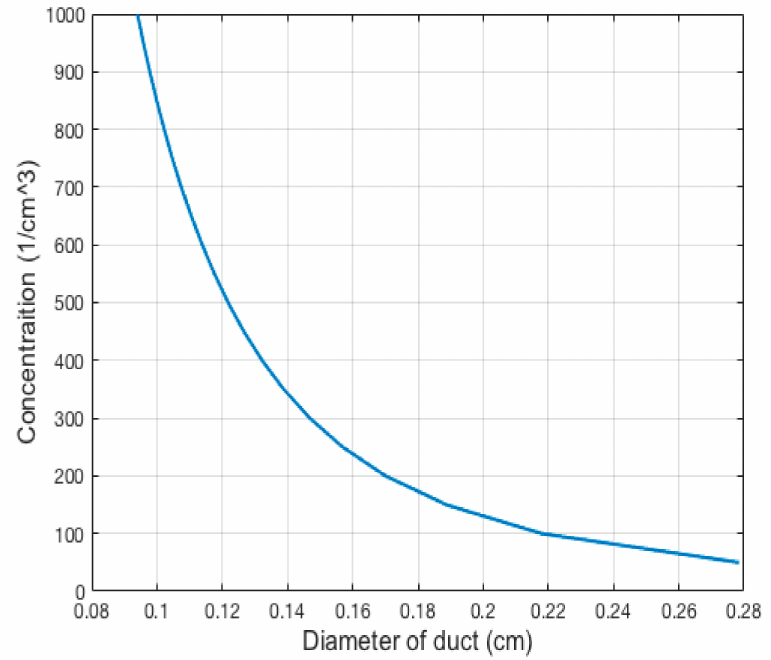
Figure 2. Number concentration vs. the inlet duct